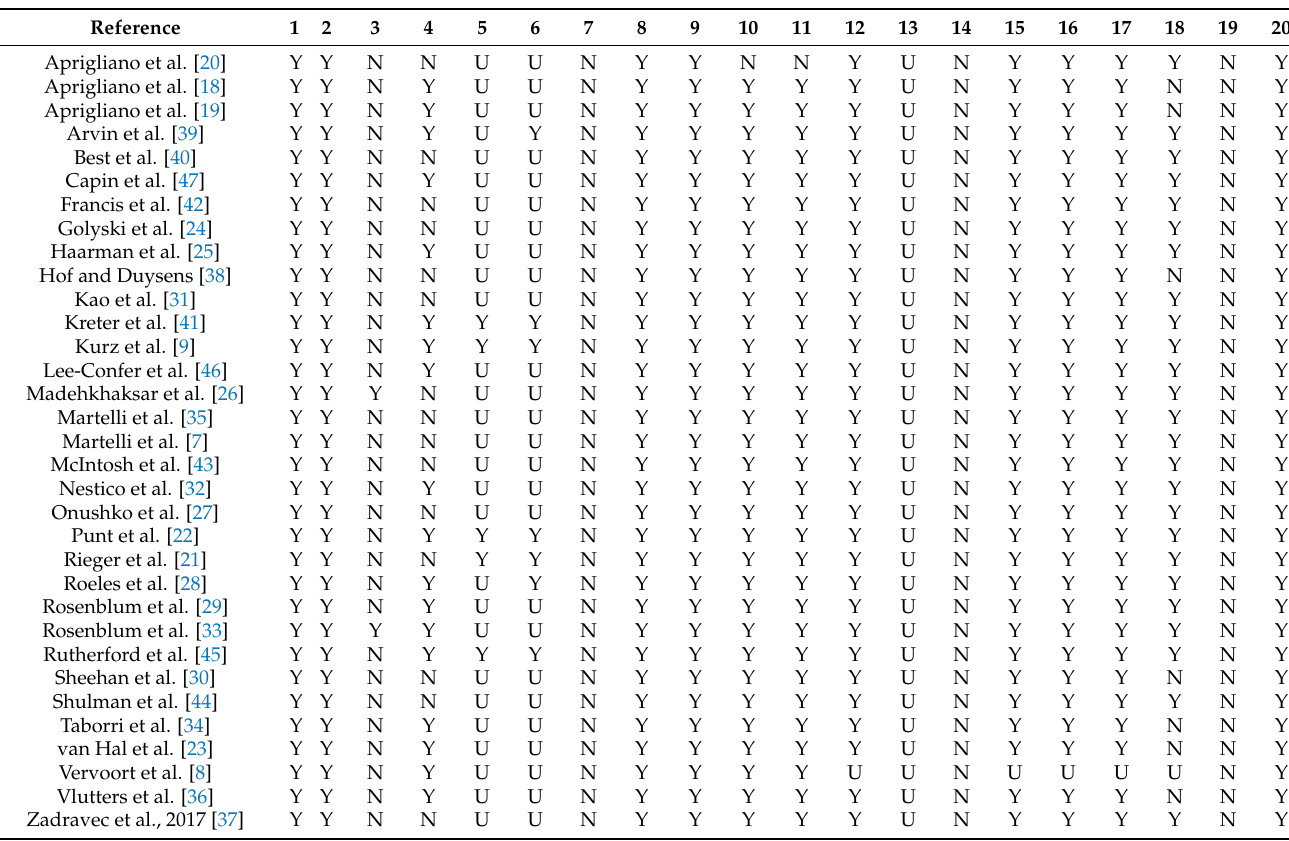
Table A1. Full risk of bias